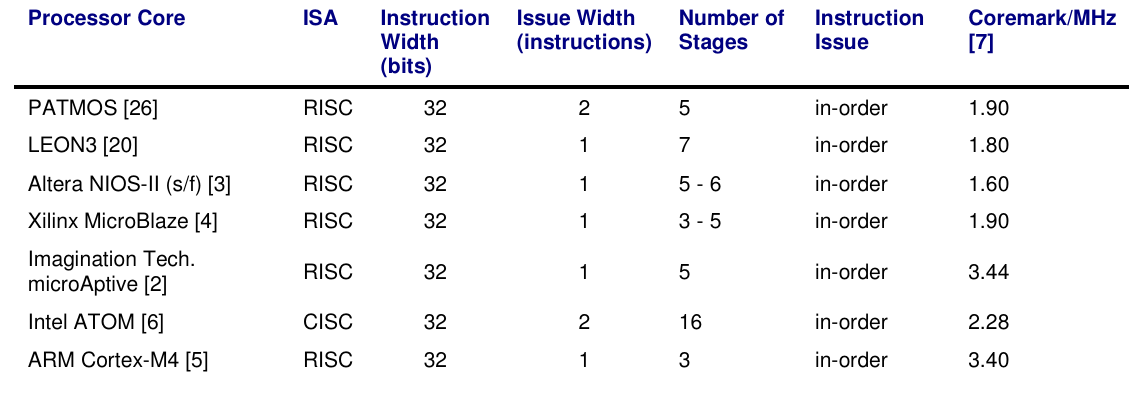
Table 1. List of academic and commercial embedded processors. ISA refers to the processor/core instruction-set- architecture which can be either CISC (Complex-Instruction-Set Computer) or RISC (Reduced-Instruction-Set Computer).